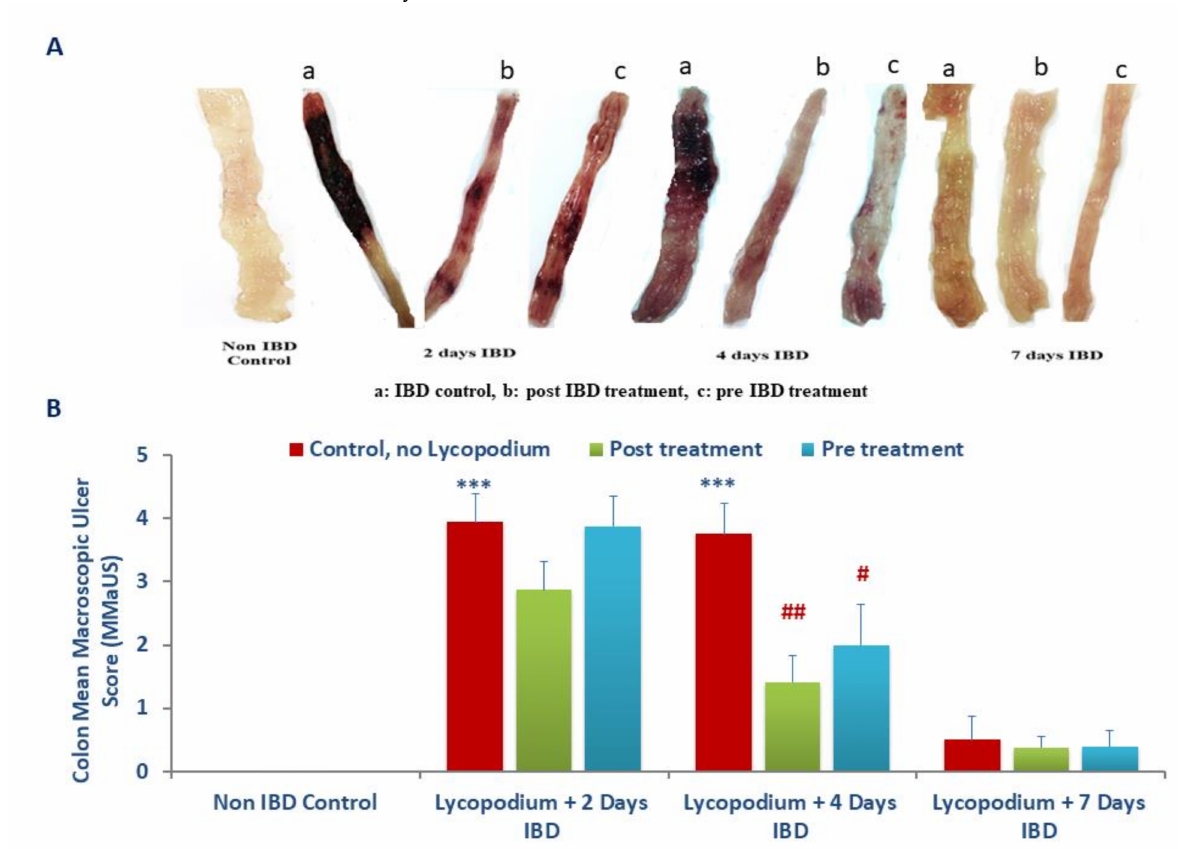
Figure 3. ( A ) Effect of lycopodium on macroscopic image (a: IBD control, b: post IBD treatment, c: pre IBD treatment) and ( B )) ulcer score in rat model of IBD. *** p < 0.001 vs. non IBD control group; # p < 0.05, ## p < 0.01 vs. relative IBD control